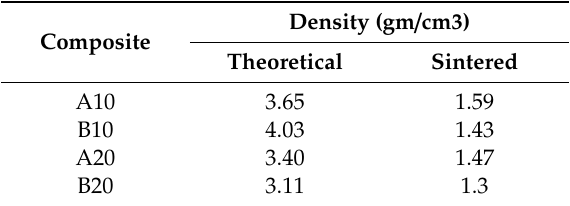
Table 2. Theoretical and sintered density of the composites.